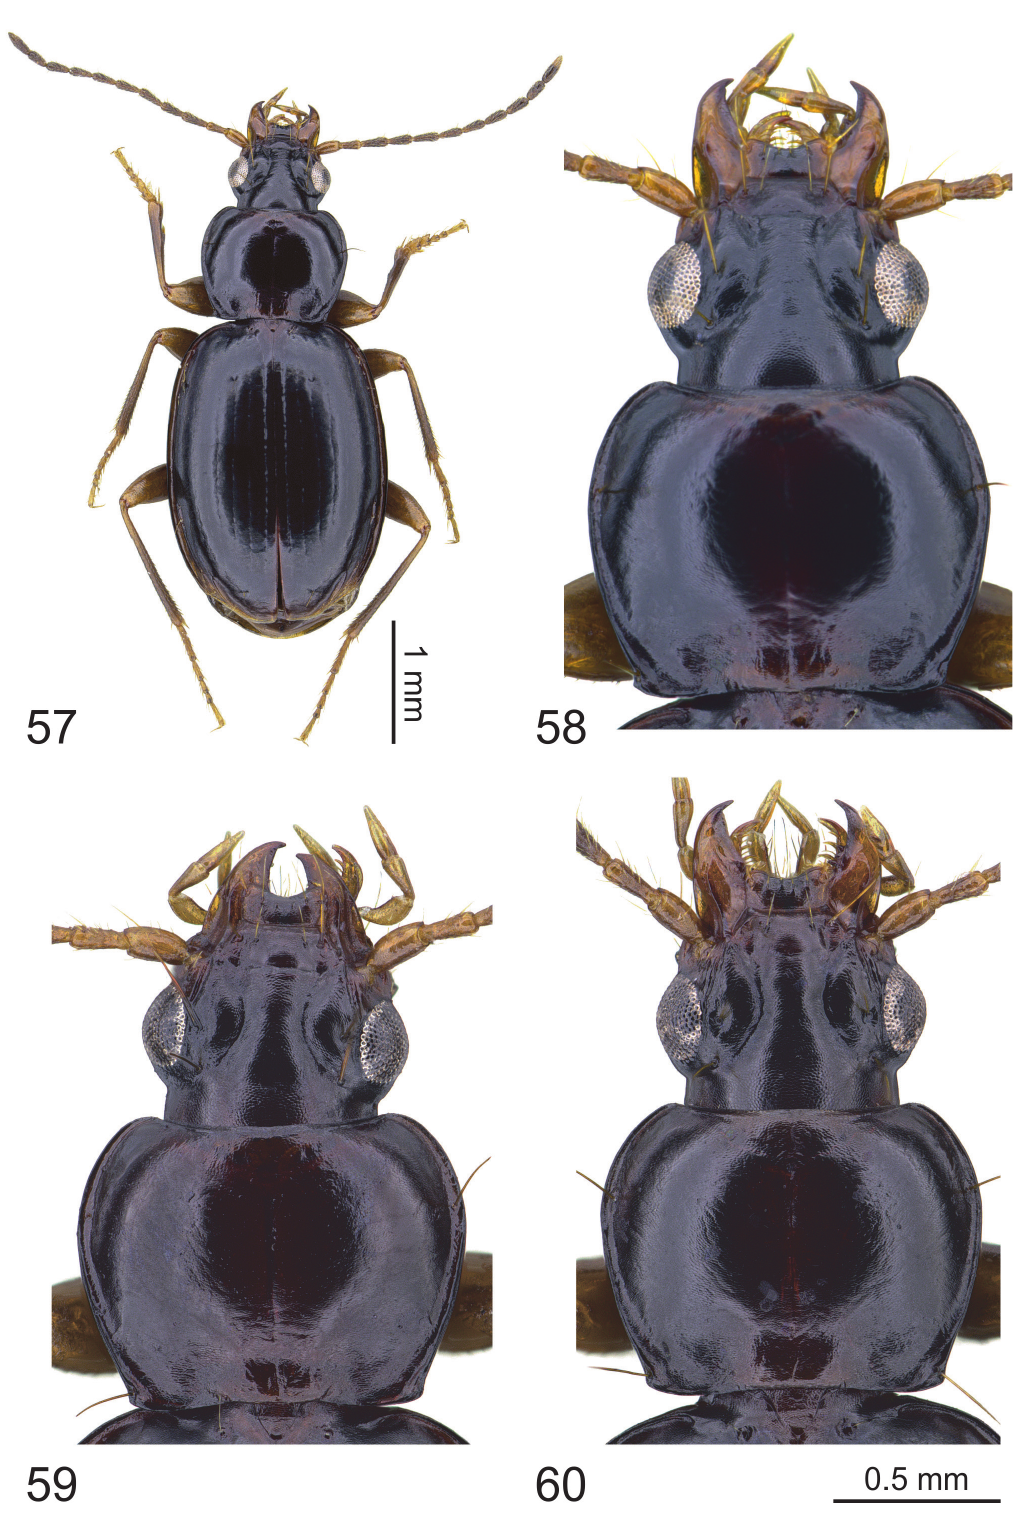
Figs 57–60. Trechus oromiensis Magrini, Quéinnec & Vigna Taglianti, 2012, habitus (57) and head, pronotum (58–60). 57–58 . ♂ from Mt Chillalo. 59 . ♂ from Mt Enkuolo. 60 . ♂ from Goba, Bale Mts, locus typicus of T. oromiensis